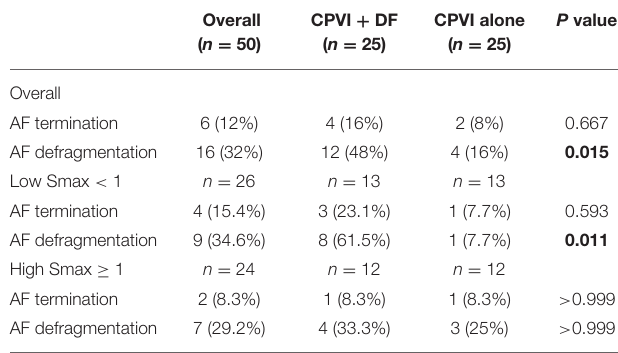
TABLE 2 | The rate of AF termination or defragmentation after virtual